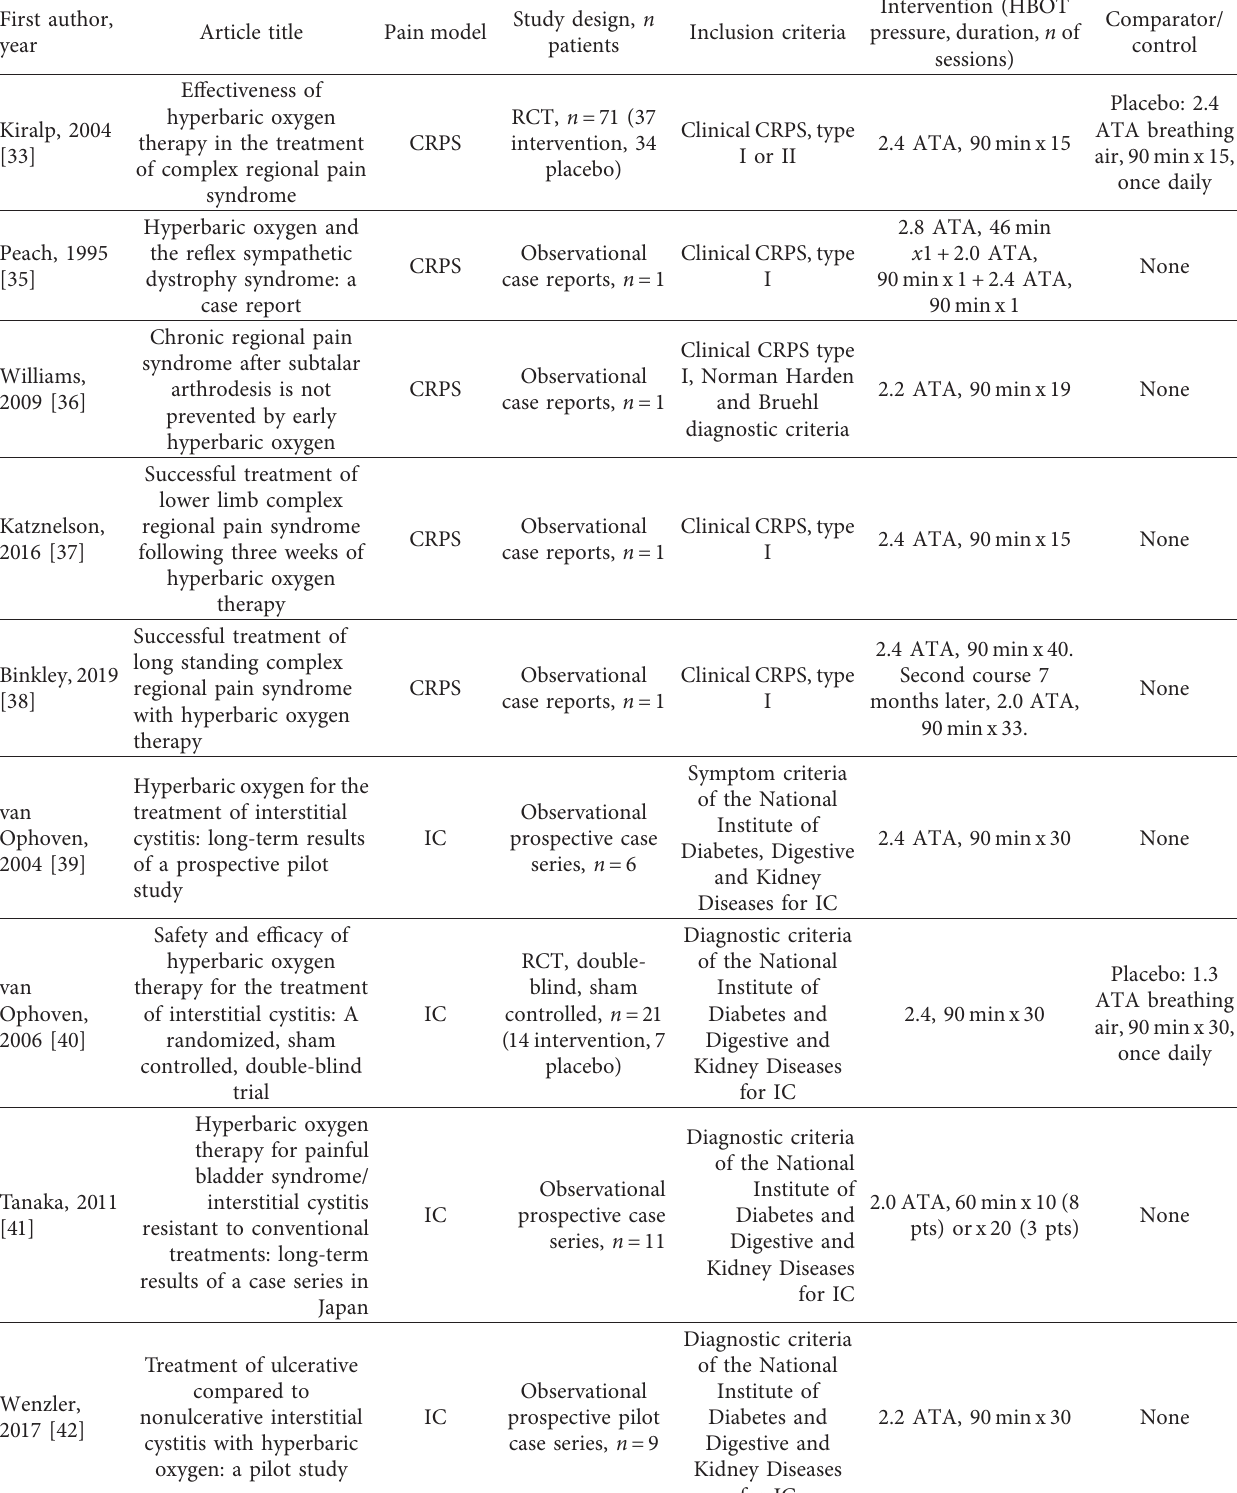
Table 6: HBOT and neuropathic pain–human studies